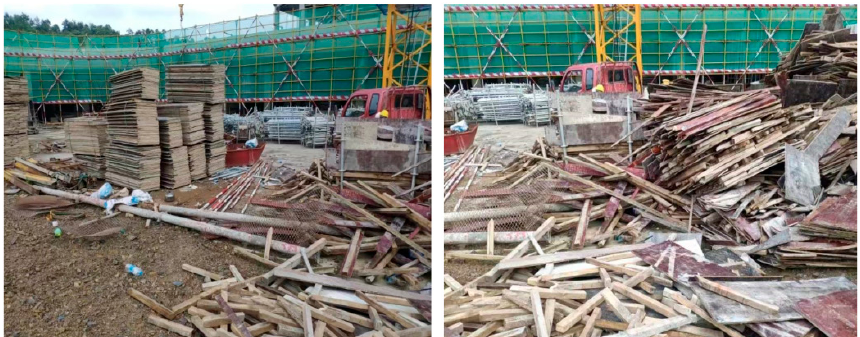
Figure 9. Monitoring scene of a woodworking shed.